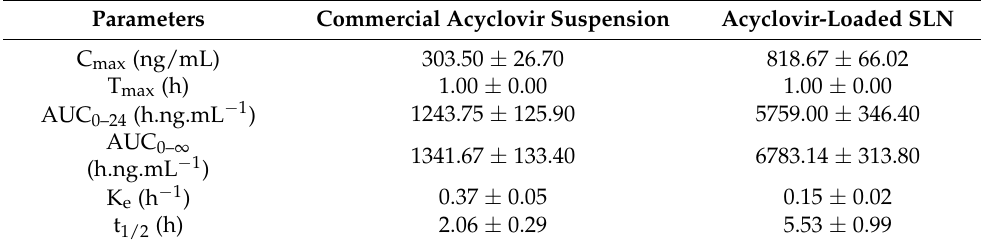
Table 5. Pharmacokinetic parameters after oral administration of acyclovir-loaded SLN or commercial suspension. Parameters